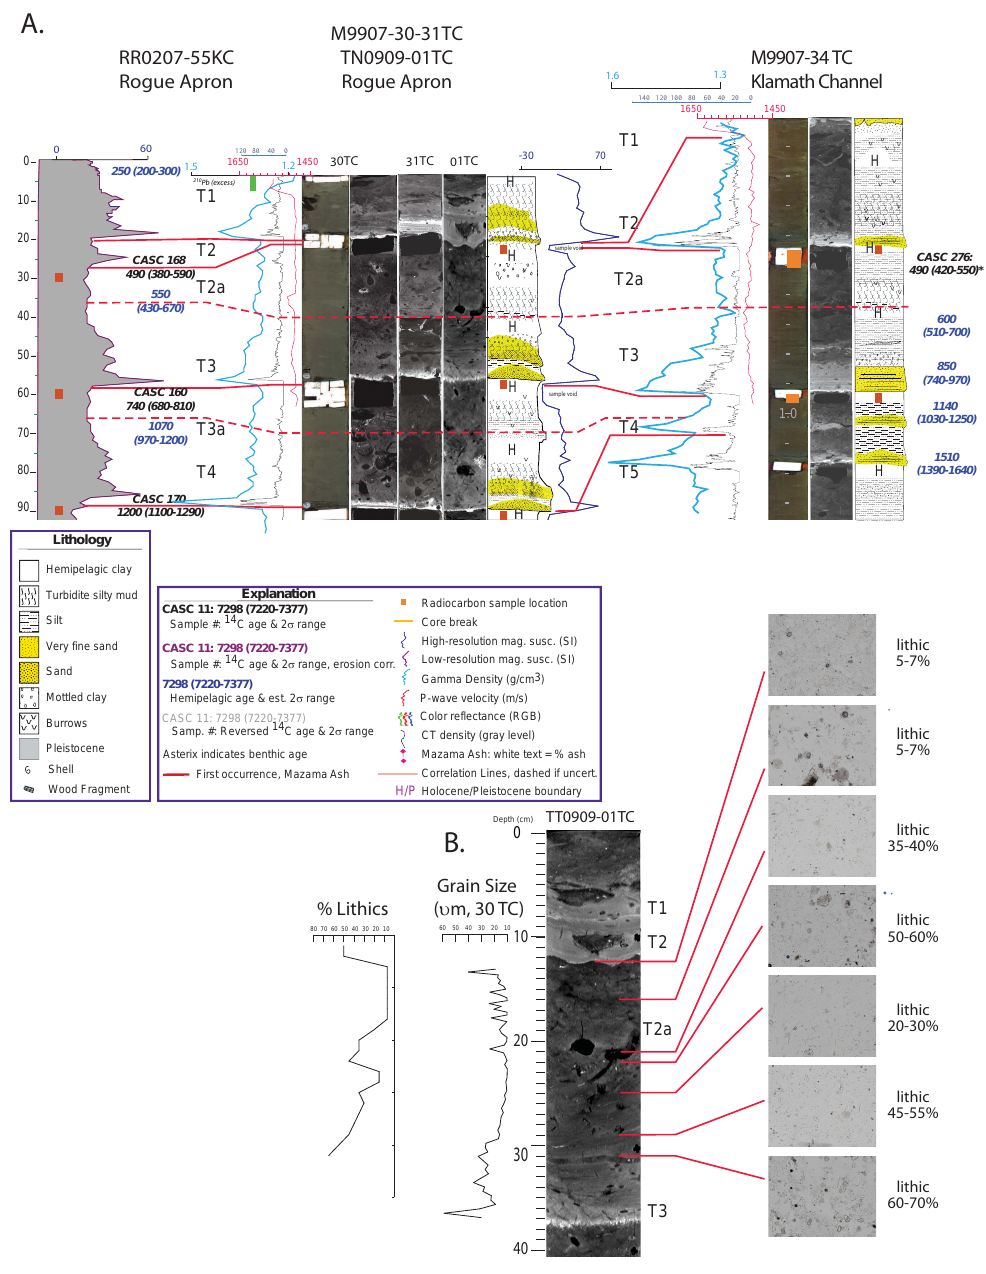
Fig. 5. (A) Details of events from the surface to T4, Rogue Apron and Klamath Channel, emphasizing small events T2a and T3a. Detailed magnetic susceptibility, gamma density and P wave velocity records and CT imagery reveal fine-grained mud turbidites between T2 and T3, and T3 and T4, which were originally logged as “dark” clay. Lithologic detail is summarized from cores 55KC, 30TC, 31TC, TT0909- 01TC (Rogue), and 34TC (Klamath). Hemipelagic ages and ranges are calculated from the age model using hemipelagic thickness, and sedimentation rates and 14 C. T1 has apparently eroded into T2 in core 30PC (center) but remains distinct in the Kasten core (left) and in 34TC with hemipelagic sediment between them. CT imagery for both 30 and 31TC, and 01TC are shown for comparison, this imagery is “flattened” on major horizons in 30TC. (B) Detail of CT and smear-slide data from core TN0909-01TC. Smear slides taken in a transect across T2a show the lithic content from hemipelagic material consisting of ∼ 30% clay, 5–7% lithics, and ∼ 65% biogenic material. T2a is 50–60% lithic, the thin bioturbated interval of hemipelagic sediment below is 20–30% lithic, and the tail of T3 is 30–70% lithics. The biogenic material in the tail of T2a is rich in heterogeneous patches of glass sponge spicules transported from shallower water. The grain size plot across T2a in M990730TC is shown and “flattened” to the lithology in 01TC in (B)